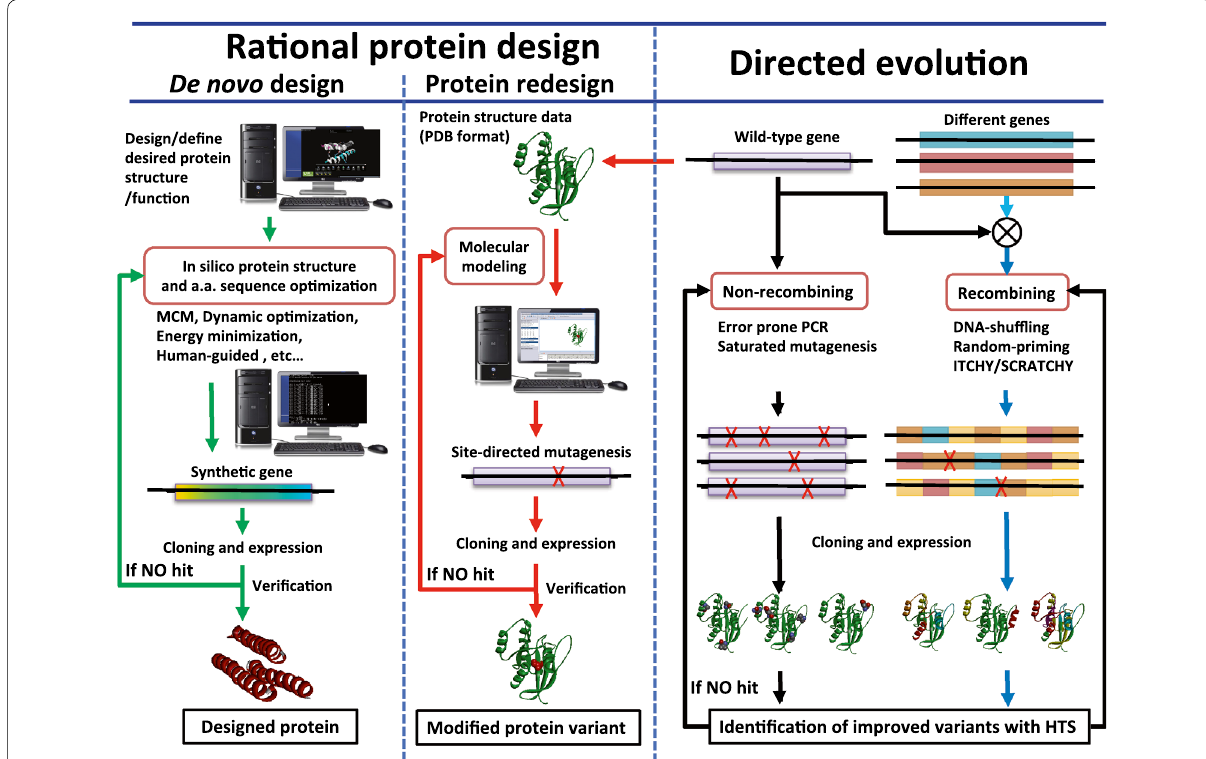
Fig. 17 Two general strategies and their procedures for protein